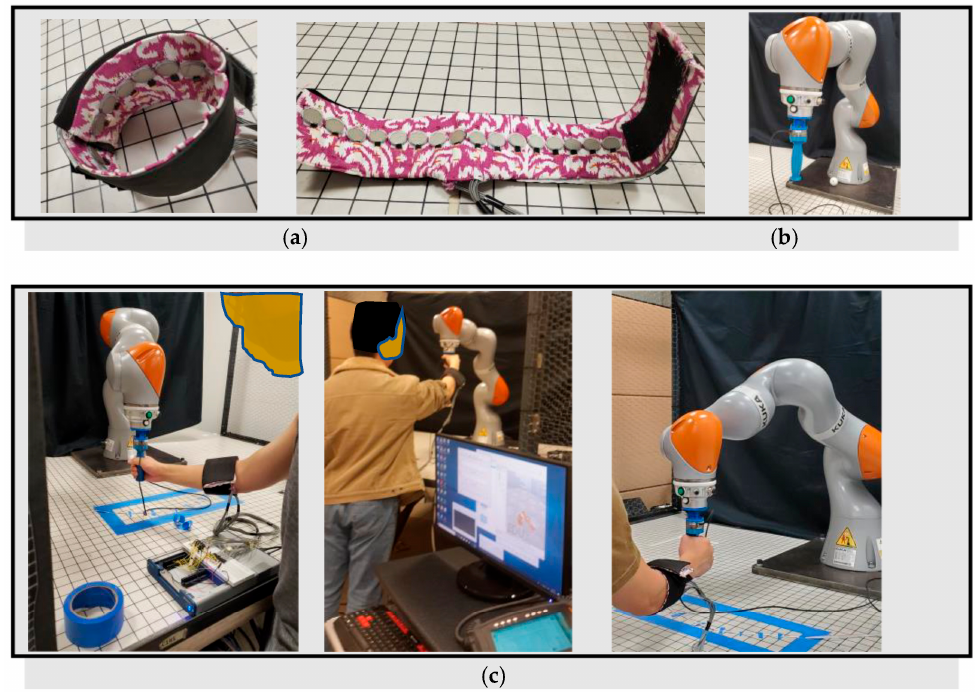
Figure 2. The pHRI setup: ( a ) 16-channel FMG forearm band, ( b ) Kuka robotic arm with cylindrical gripper, ( c ) regular, preset activities between a human participant and the Kuka robotic arm.